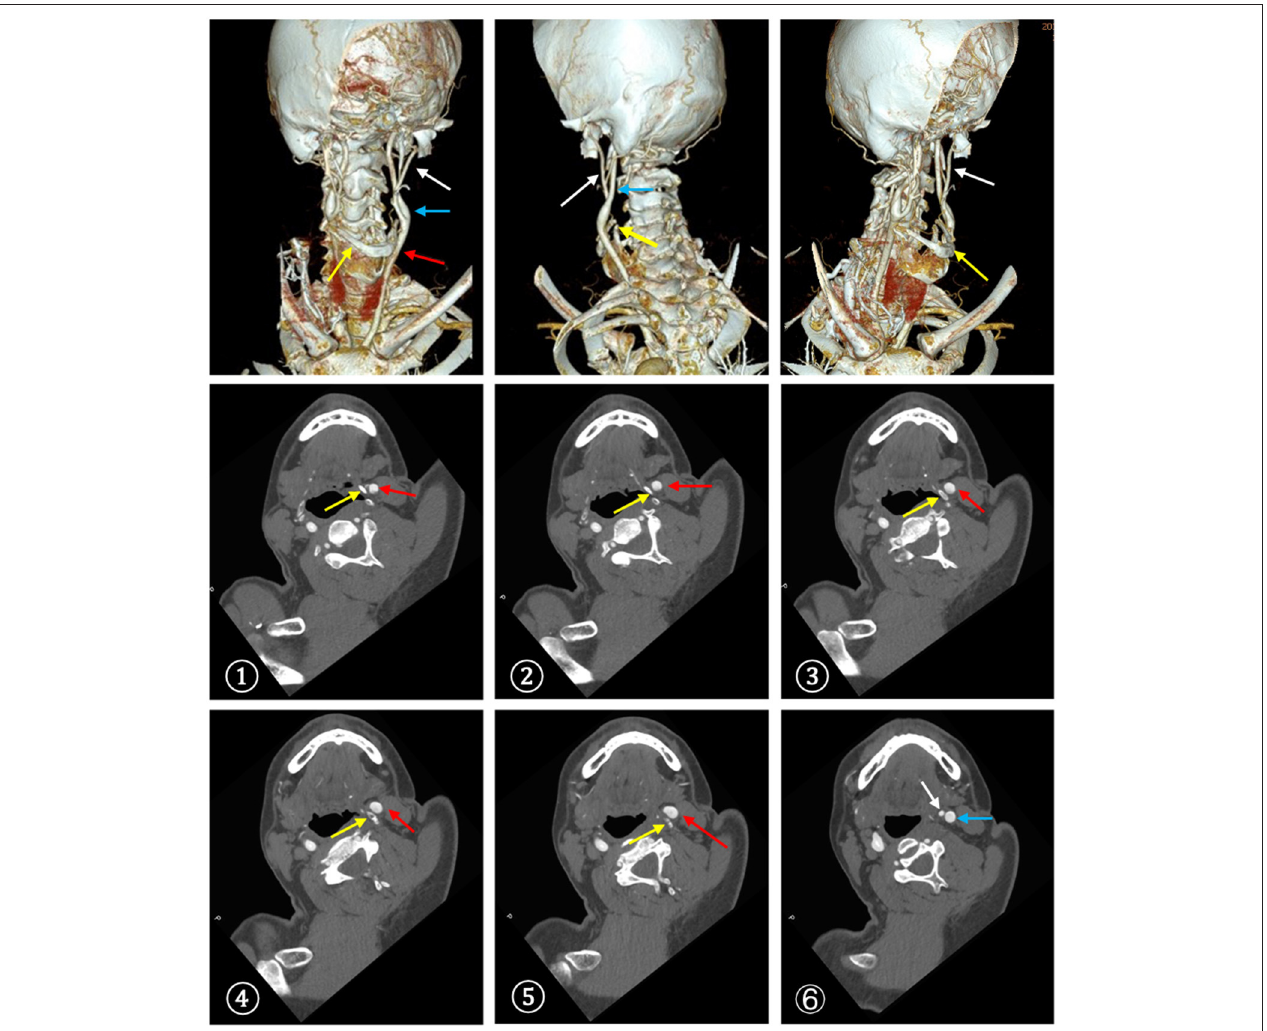
FIGURE 3 | CTA demonstrated a close contact between the enlarged left greater horn of the hyoid bone and the carotid bifurcation. ‹ - – , The serial CT slices from distal CCA to proximal ICA. (red arrow: CCA, blue arrow: ICA, white arrow: ECA, yellow arrow: hyoid